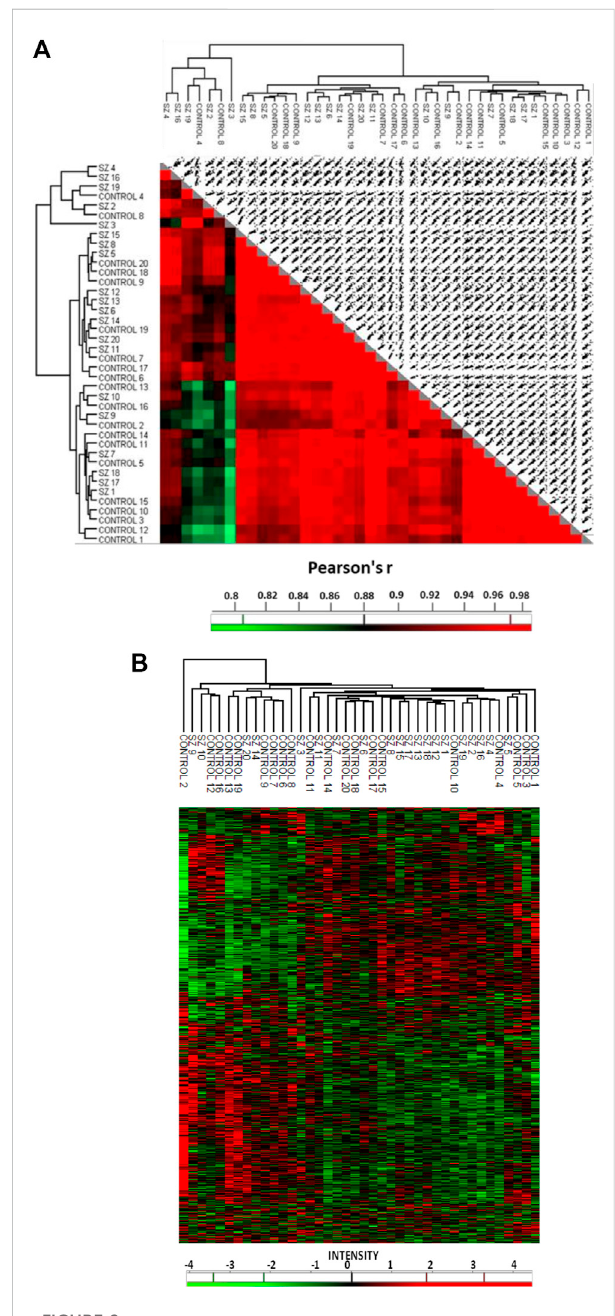
Quantitative proteomic analysis in the prefrontal cortex in schizophrenia. (A) Thecorrelationmatrixshowsthecorrelationcoef fi ciency betweenthe1989quanti fi edproteinsineachcomparedpairofsamples. (B) Unsupervised hierarchical clustering analysis from prefrontal cortex proteins. This analysis was performed with matrix processing according to the Euclidean distance and z-score aggregation method. We used 1989 quanti fi ed proteins. Green color clusters represent downregulated proteins. Red color clusters represent upregulated proteins. The intensity scalerepresentsthez-score,positivescoresshowsigni fi cantlyupregulated proteins labeled in red, while negative scores signi fi cantly downregulated proteins are labeled in green. SZ , schizophrenia; C ,